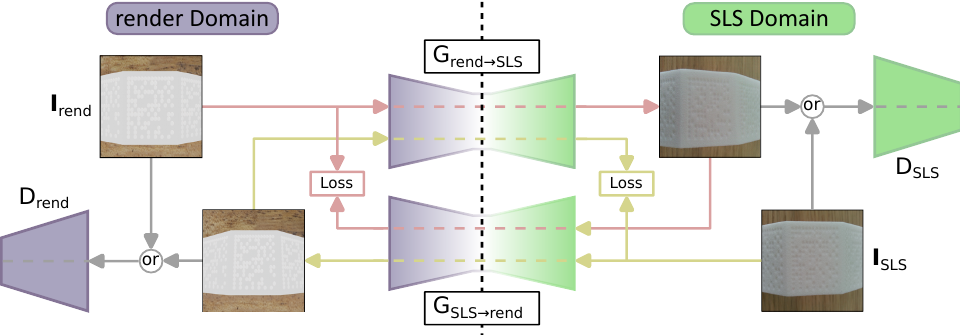
Figure 3. Overview of the GAN-based image augmentation. Images are transformed from the rendered domain to the real-world domain. The cycles are used for loss calculation and marked as red (rendered to real) and light yellow (real to